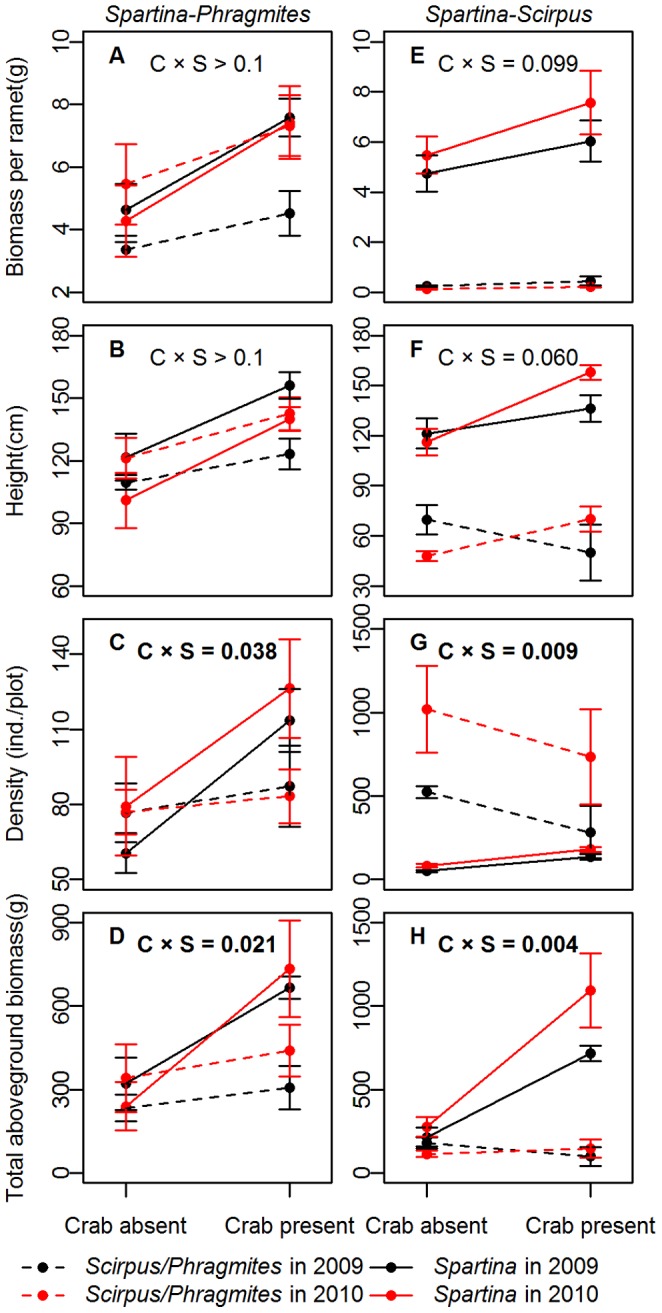
The performance of invasive vs. native plant in mixtures with or without crab disturbance.The biomass per ramet (mean ± SE, A and E), height (mean ± SE, B and F), density (mean ± SE, C and G) and aboveground biomass (mean ± SE, D and H) of invasive and native species in mixtures are presented. The P-values of interactive effects of “crab × species” are given, where “C” stands for crab treatments and “S” stands for species.